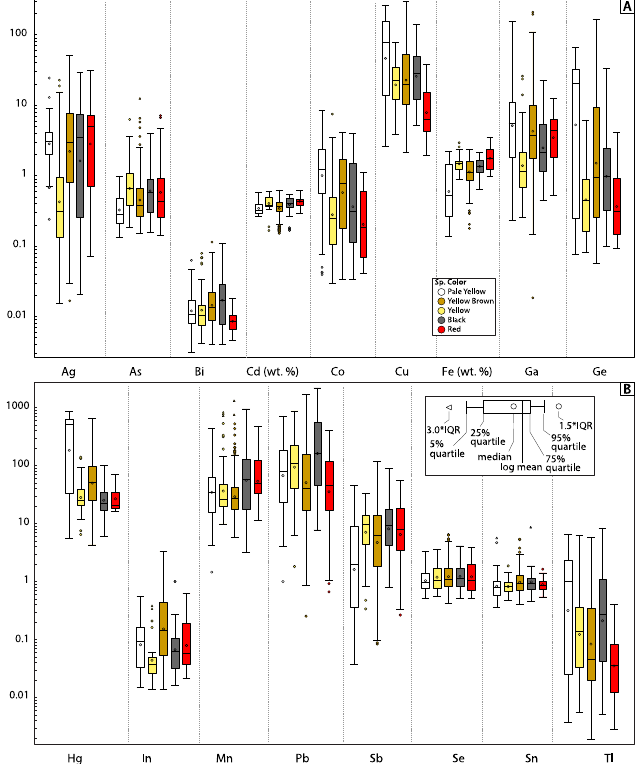
Figure 9. Box-and-whisker plots of trace elements ( A ) Ag, As, Bi, Cd, Co, Cu, Fe, Ga, Ge, ( B ) Hg, In, Mn, Pb, Sb, Se, Sn, and Tl in sphalerite distinguished by color. All units are in ppm except Cd and Fe (wt. %). Note the logarithmic scale and corresponding mean value.